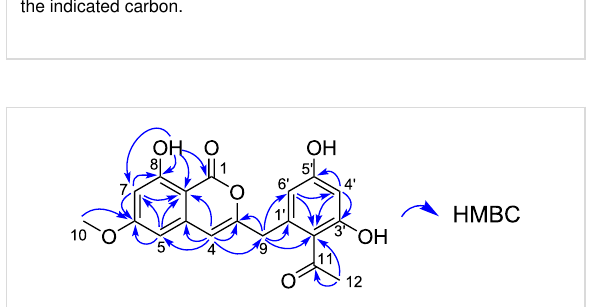
Figure 3: Key HMBC correlations for karimunone B ( 2